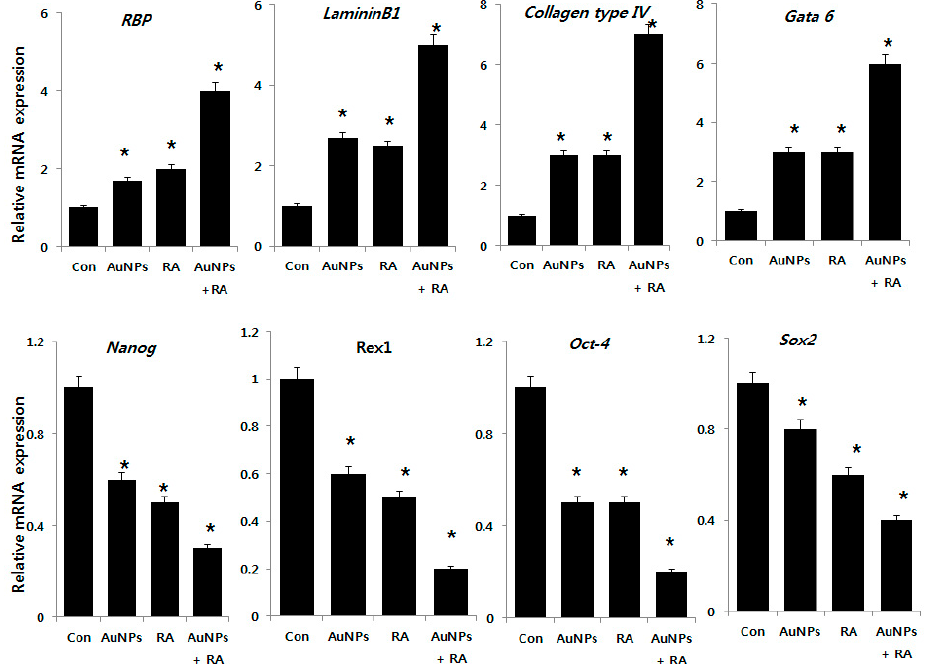
Figure 10. Analysis of expression of various differentiation and pluripotency stem cell markers. AuNPs-induced differentiation of F9 was determined after 24 h exposure to AuNPs (10 µ M), RA (10 µ M), and RA in the presence of AuNPs (both 10 µ M). The expression pattern of the differentiation markers retinoic acid binding protein (RBP) , laminin 1 , collagen type IV , and Gata6 and stem cell pluripotency markers Nanog , Rex1 , Oct-4 , and Sox-2 were analyzed in cells exposed to AuNPs (10 µ M), RA (10 µ M), and RA in the presence of AuNPs (both 10 µ M). After 24 h treatment, the expression level was determined as fold-changes in reference to expression values of GAPDH. At least three independent experiments were performed for each sample. The treated groups showed statistically significant differences from the control group by the Student’s t -test (* p ,